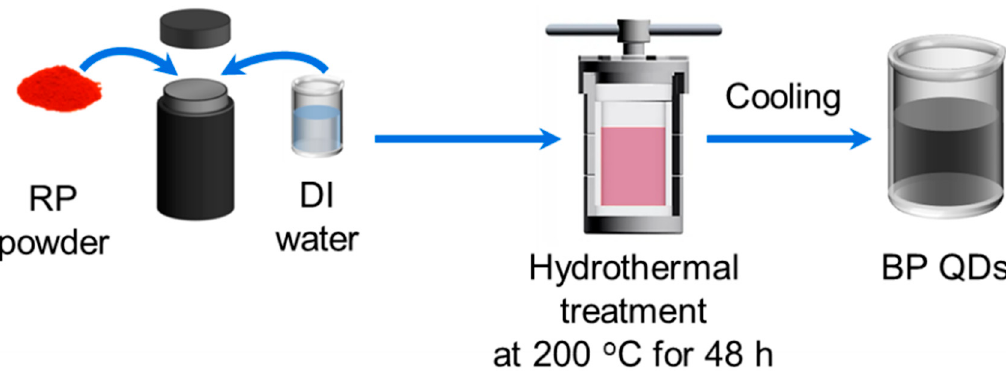
Figure 1. Aqueous preparation procedure of BP QDs from RP via the hydrothermal method.